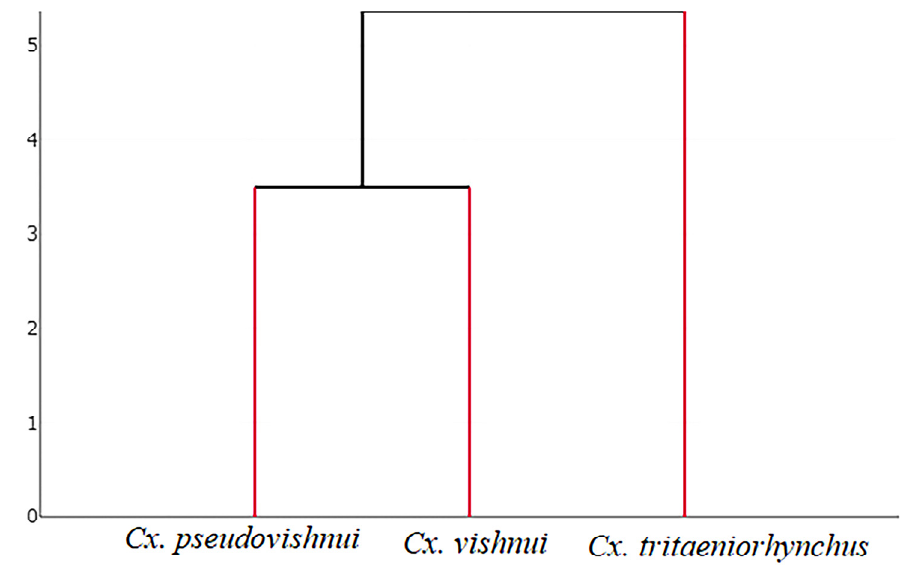
Figure 7. Hierarchical clustering tree based on wing shape among Cx. pseudovishnui , Cx. tritaeniorhynchus , and Cx. vishnui . The UPGMA algorithm is used to create a hierarchical clustering tree based on Mahalanobis distances between average group shapes. Table 2. Statistical differences of Mahalanobis distance values based on wing shapes of Cx. Pseu ‐